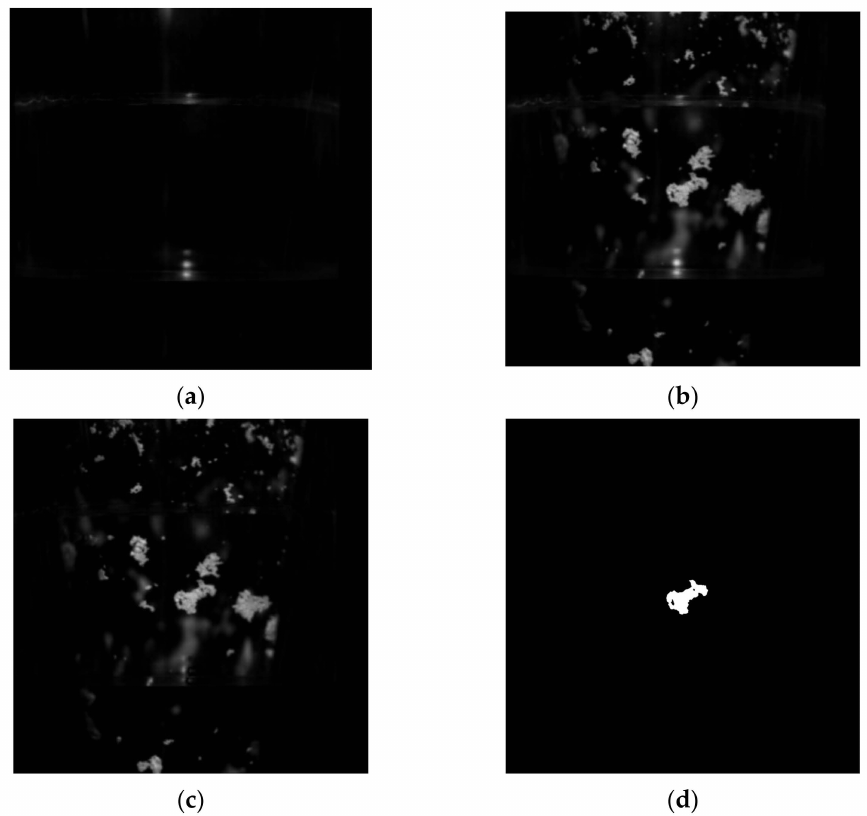
Figure 3. Images during the image processing: ( a ) cyclone separator-evaporator without dry ice particles; ( b ) cyclone separator-evaporator with dry ice particles; ( c ) dry ice particles after filtering light reflection; ( d ) binarized image of targeted